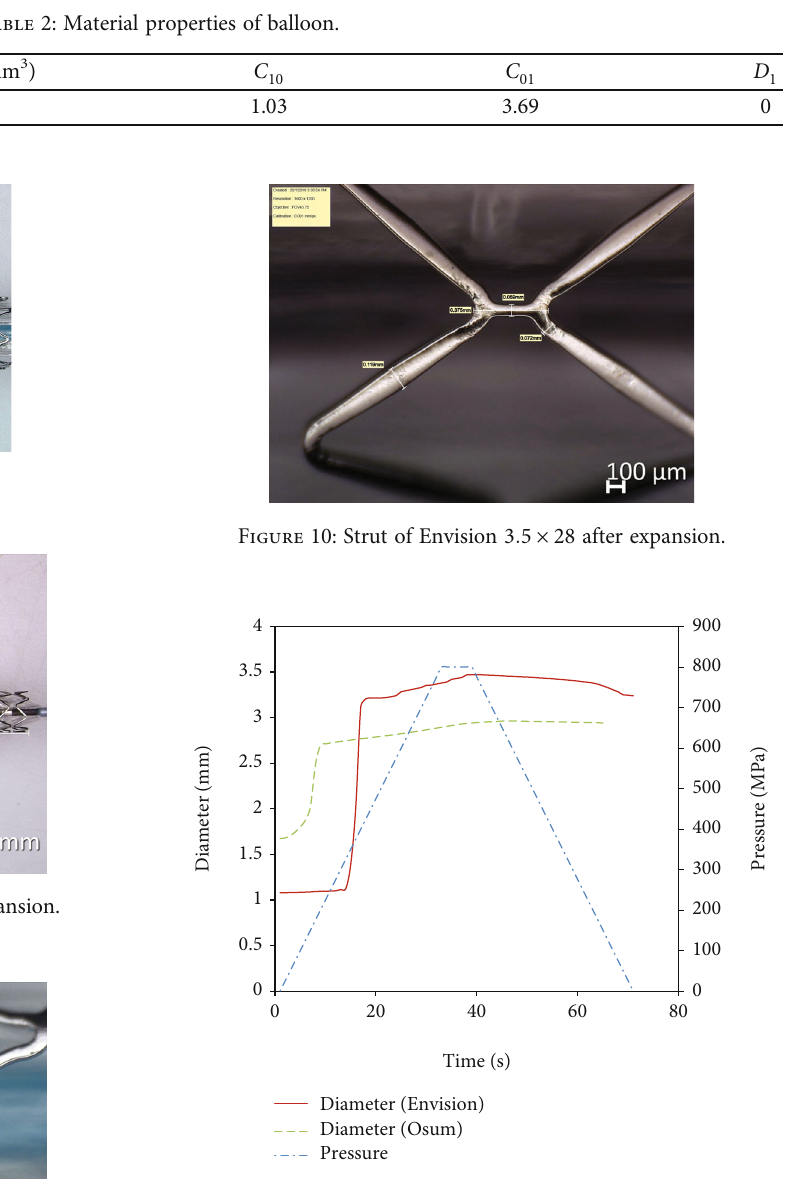
Figure 11: Stent expansion with pressure.